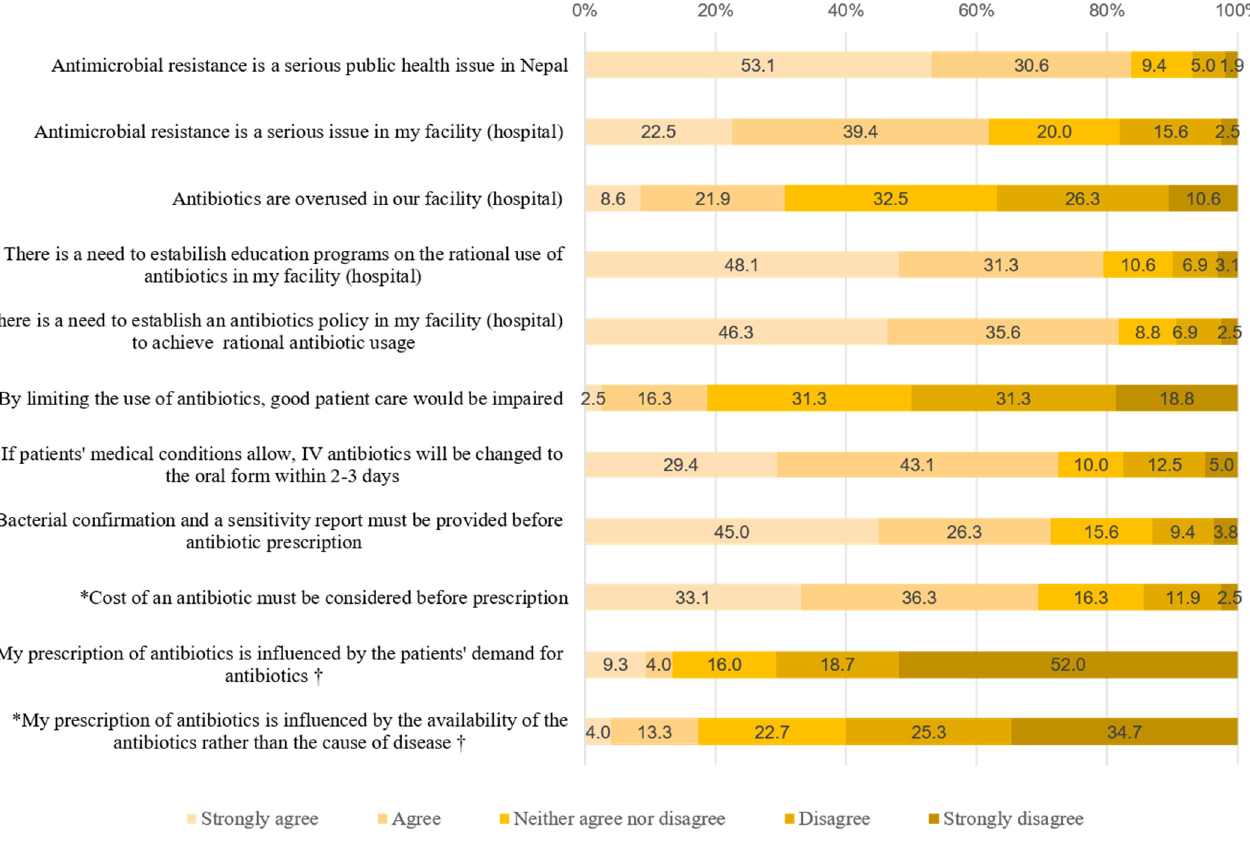
Figure 2. Results of the attitudes and practices test (n=160). * Questions regarding the factors that influence antibiotic prescription. † asked only of physicians who have prescribing authority.